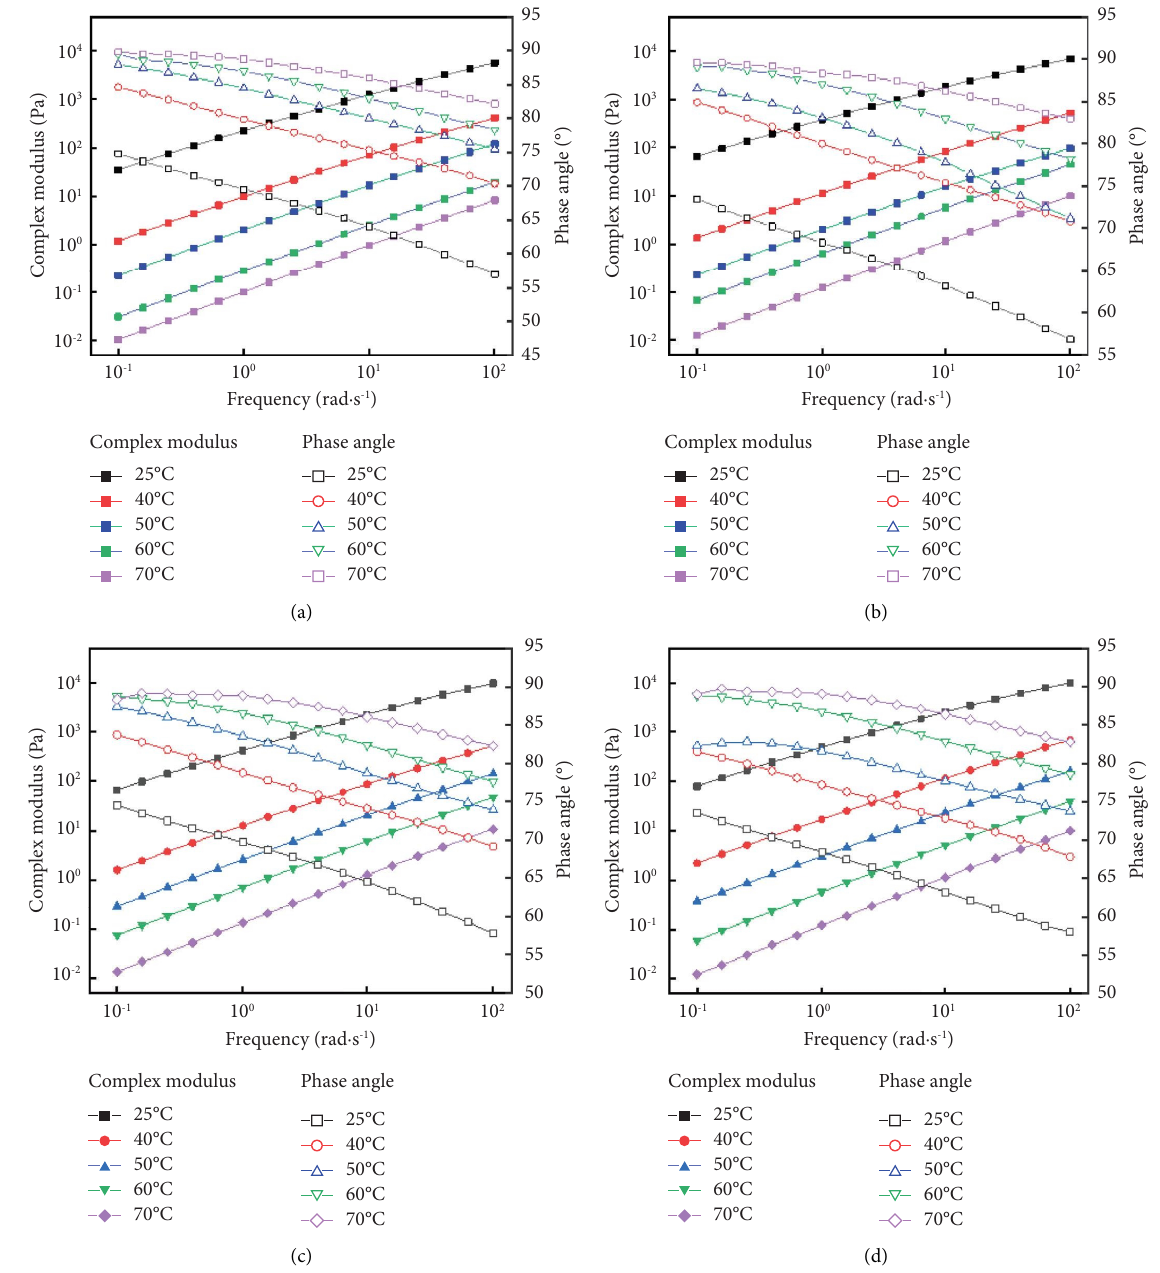
Figure 1: G ∗ and δ change curves of 70# asphalt under diferent aging times. (a) 76.25h. (b) 152.5h. (c) 228h. (d)